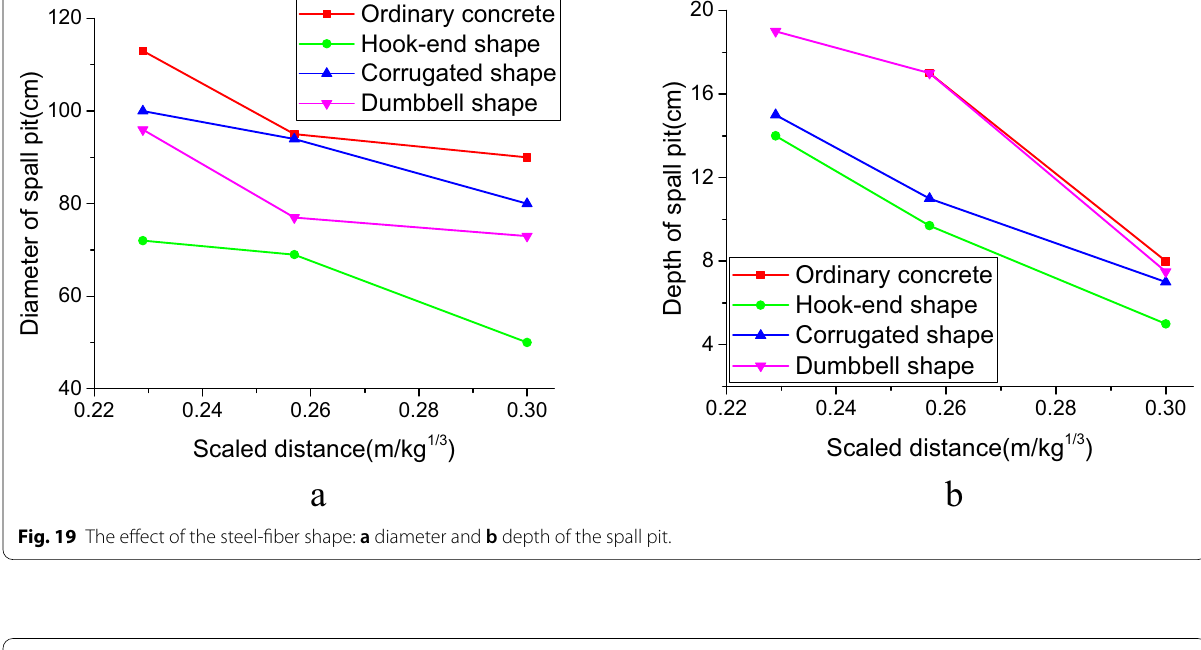
Fig. 19 The effect of the steel-fiber shape: a diameter and b depth of the spall pit.